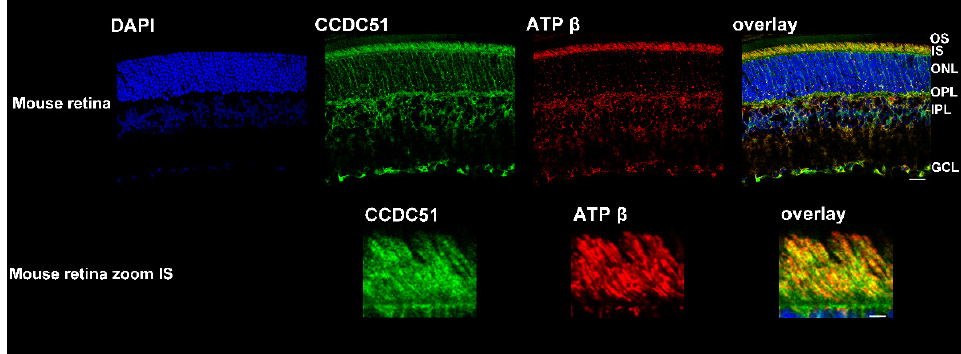
Figure 6. Detection of CCDC51 in mouse retina. Top: A mouse retinal section showed CCDC51 immunolocalization with the anti-CCDC51 antibody in different retinal cell layers (green and yellow). A similar staining with the mitochondrial mouse anti-ATP synthase subunit beta antibody (red and yellow) was obtained (bar = 20 μ m). The enlarged images showed that the CCDC51 and ATP synthase subunit beta staining was found in close proximity, with some overlap in the inner segment of both rod and cone photoreceptor cells (zoom, green and red, respectively, and yellow). Nuclei were stained with DAPI (blue) (bar = 3 μ m).